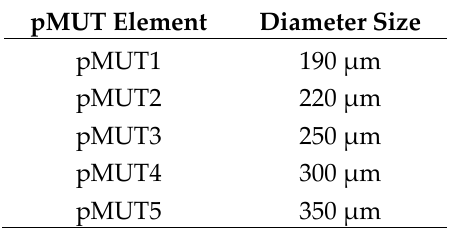
Table 1. Diameter size of each pMUT element in the array.